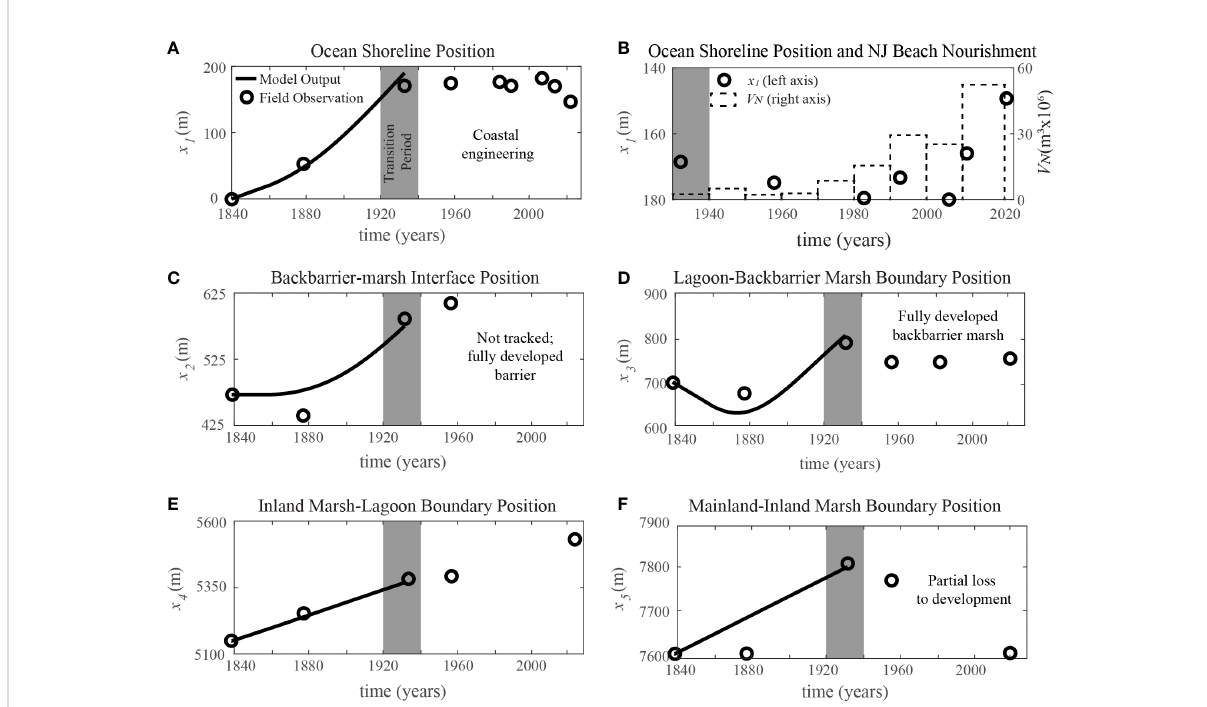
FIGURE 6 Evolution of the geomorphic moving boundaries (A – F) during phases 1 and 2. See Figure 4B for a schematic of model geometry that includes the boundaries being tracked, x 1 to x 5 . The input parameter values are included in Supplementary Table 3. Ocean shoreline position compared to decadal Long Beach Island beach nourishment volume (V N ) (B)